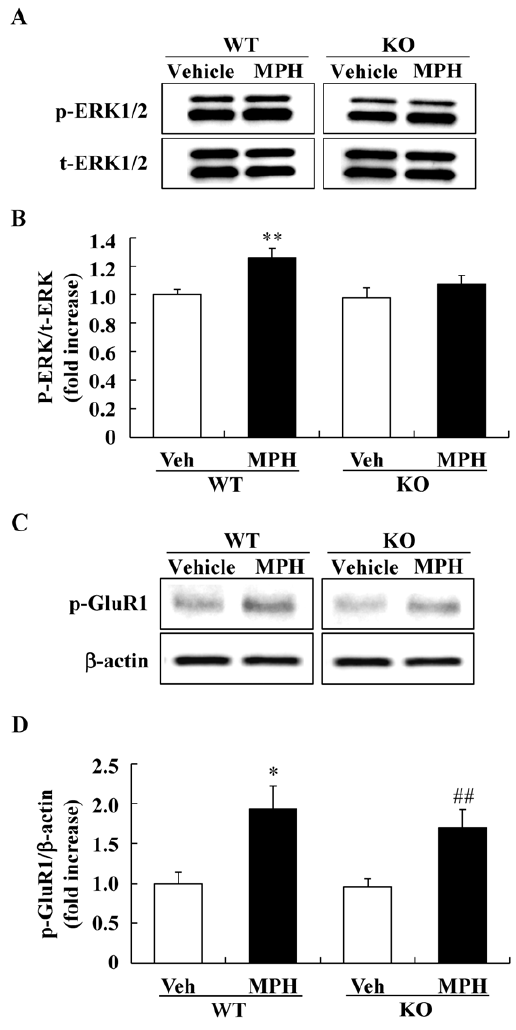
Figure 5. Western blot analysis of the phosphorylation levels of ERK1/2 and GluR1 in the striatum. Phosphorylated and total ERK1/2 levels in the striatum were measured by Western blot analysis. (A) Representative immunoblots showing the expression levels of phosphorylated ERK1/2 (p-ERK1/2) and total ERK1/2 (t-ERK1/2) in the striatum of WT and DGK b KO mice 5 min after drug treatment. (B) Phosphorylation levels of ERK1/2 are quantified relative to the t-ERK1/2 levels. Values are expressed as the mean 6 S.E.M. (n=5 to 8) **; p , 0.01 v.s. vehicle-treated WT mice group ( t -test). (C) Representative immu- noblots showing the expression levels of phosphorylated GluR1 (p- GluR1) in the striatum of WT and DGK b KO mice 40 min after drug treatment. (D) Phosphorylation levels of GluR1 are quantified relative to the b -actin levels. Values are expressed as the mean 6 S.E.M. (n=6 to 8) *; p , 0.01 vs. vehicle-treated WT mice group, ## ; p , 0.01 vs. vehicle- treated KO mice group ( t -test).